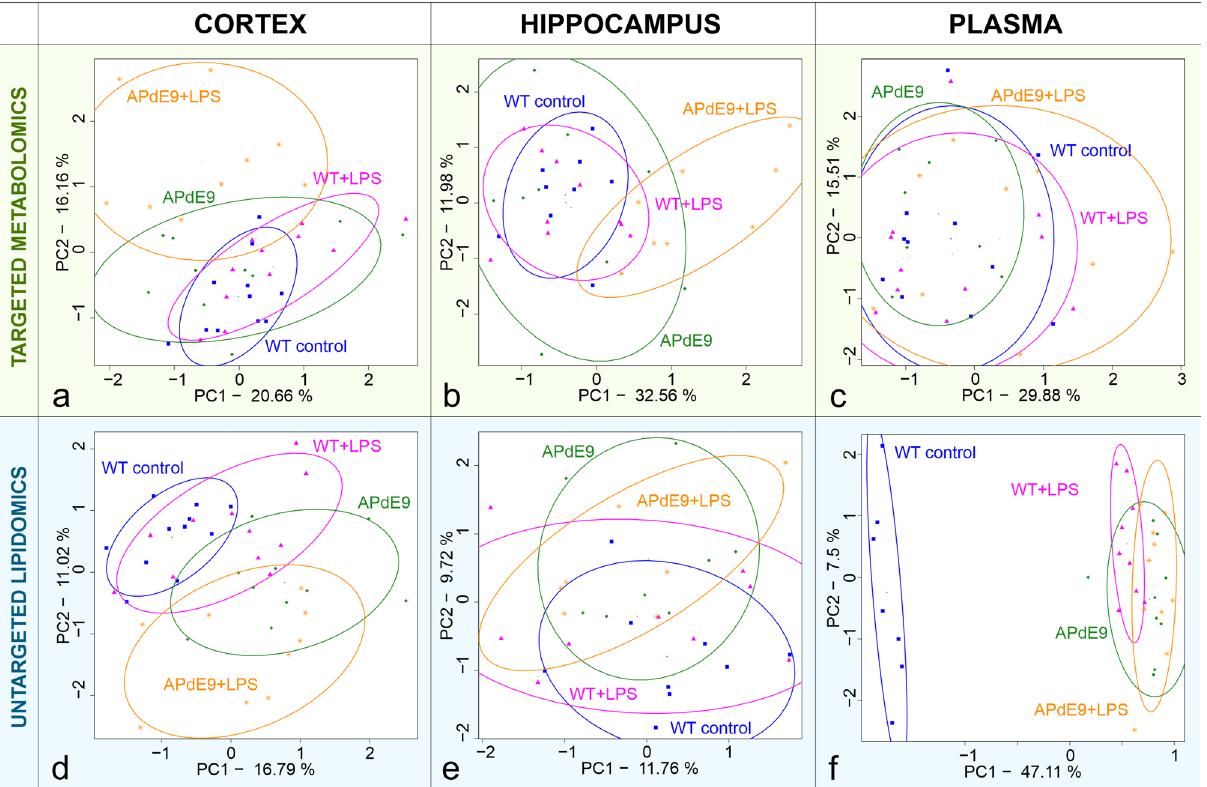
Figure 1. Principal component analysis (PCA) score plots for each model and analytical approach studied to compare global differences in the metabolomic ( a – c ) and lipid composition ( d – f ) of the hippocampus, cortex and plasma in all the groups that were Table S1 online) was observed for various metabolites in the APdE9 plus LPS mice compared to the APdE9 mice. According to the biochemical pathway analysis, LPS administration did not cause any significant changes in metabolite levels in the cortex and hippocampus of WT mice. The significant increase in arginine and N -for- mylglycinamide ribonucleotide was observed in the cortices of the APdE9 mice. The LPS treatment in the the APdE9 mice significantly increased the cortical levels of lysine, myo-inositol and hippocampal levels of sper- mine. Moreover, the reduction the hippocampal phosphocreatine levels and several metabolites involved in nicotinamide metabolism were observed in the APdE9 plus LPS mice. (Fig. 3, Supplementary Table S1 online). Interestingly, there was a decreasing trend in the levels of various short- and medium-chain acylcarnitines in the hippocampus of the APdE9 mice and APdE9 plus LPS mice compared to the WT control animals (Fig. 3, Supplementary Table S1 online). Similarly, long-chain acylcarnitines demonstrated a decreasing trend in the cortex of these two models as compared to the WT control. Statistically significant changes were observed for acylcarnitines (C16, C18:2, C16OH) in the APdE9 plus LPS mice compared to WT control group (Fig. 3, Sup- plementary Table S1 online).